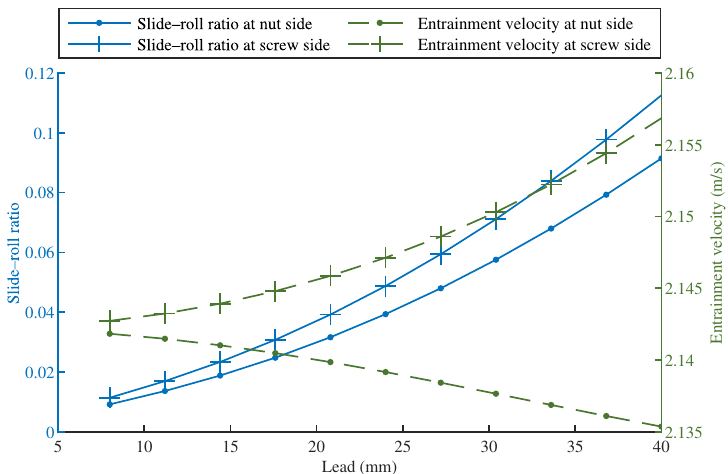
Figure 7. Slide–roll ratio and entrainment velocity under various lead